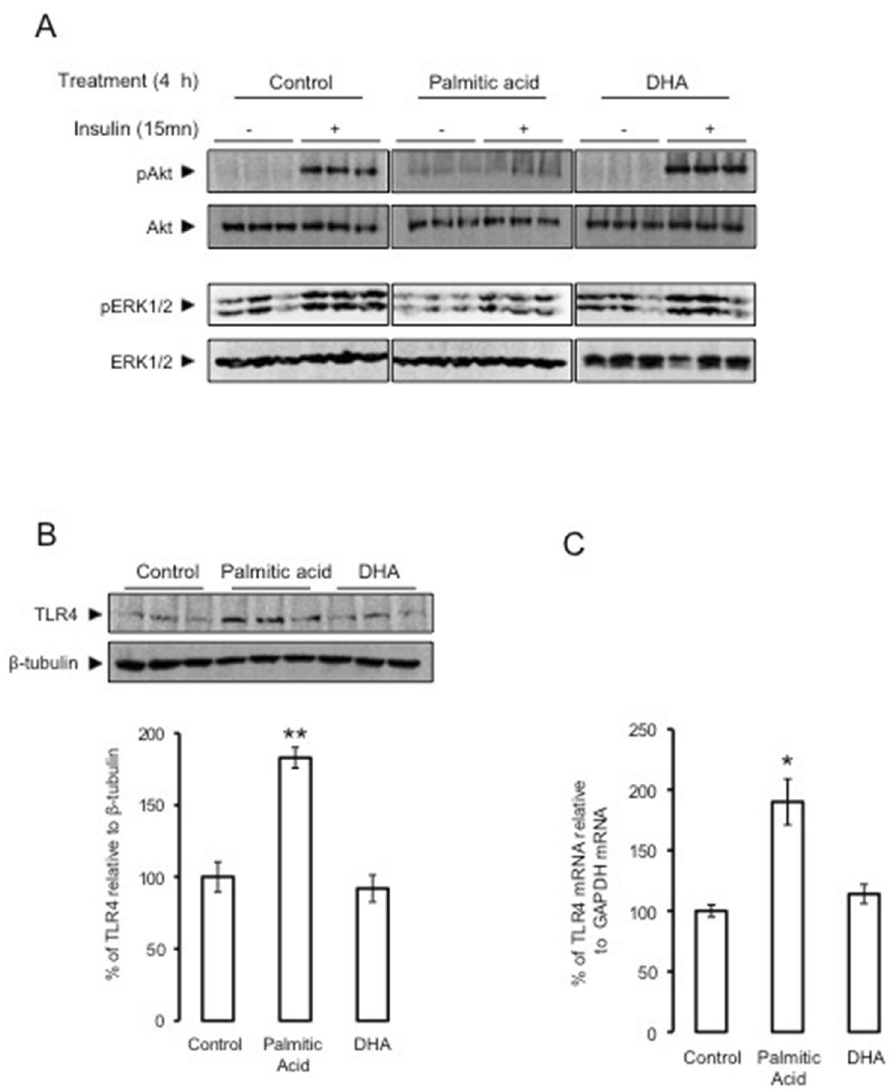
and ERK1/2 phosphorylation measured by Western blots using adequate antibodies, Control, Palmitic acid and DHA blots were performed in separate membranes, in each case the same membrane was blotted with different antobodies (panel A ); TLR4 expression was measured by Western blot using anti-TLR4 antibodies and the expression was normalized to β tubilin, and band densities were quantified and expressed as ratio of TLR4/β- tubilin (panel B ); TLR4 mRNA expression was determined by qRT-PCR normalized to GAPDH (panel C ). Western blot and qRT-PCR data were presented as means ± SEM (n = 3), * and ** denoted significant differences vs control at p < 0.05 and p < 0.005,